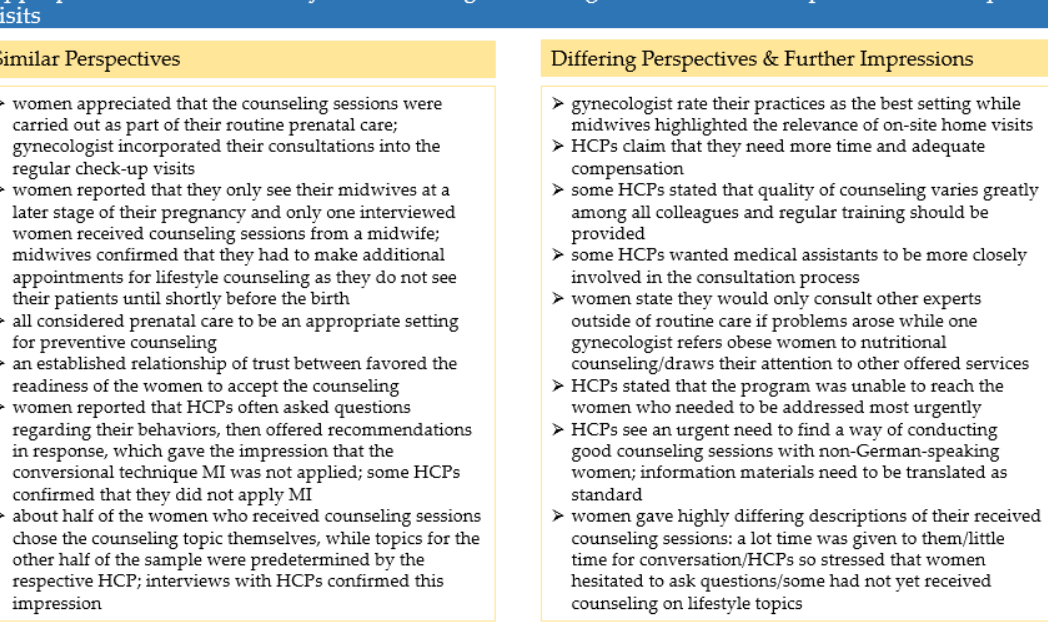
Figure 5. Summary of the results in Section 3.4.